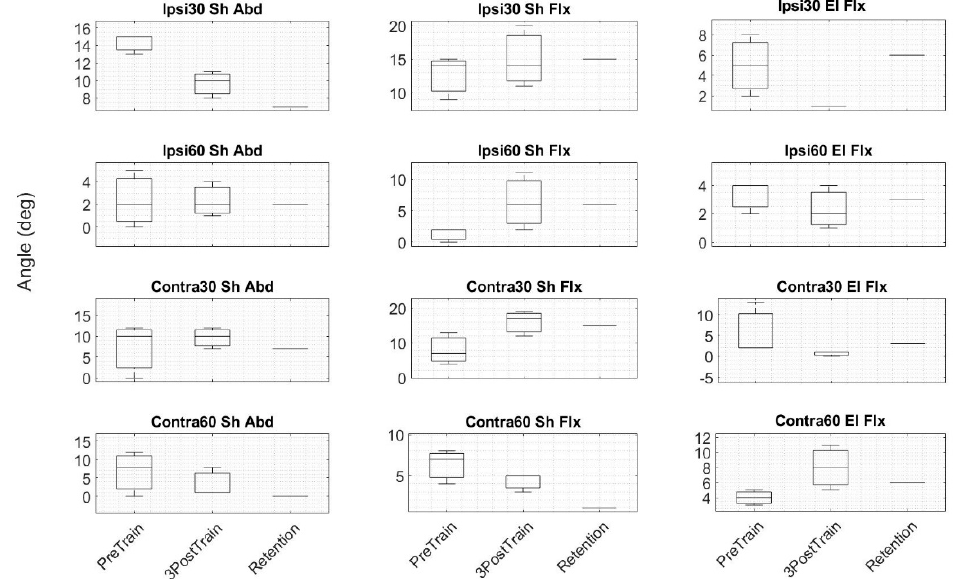
stability; 90, 90 degrees; 0, 0 degrees.